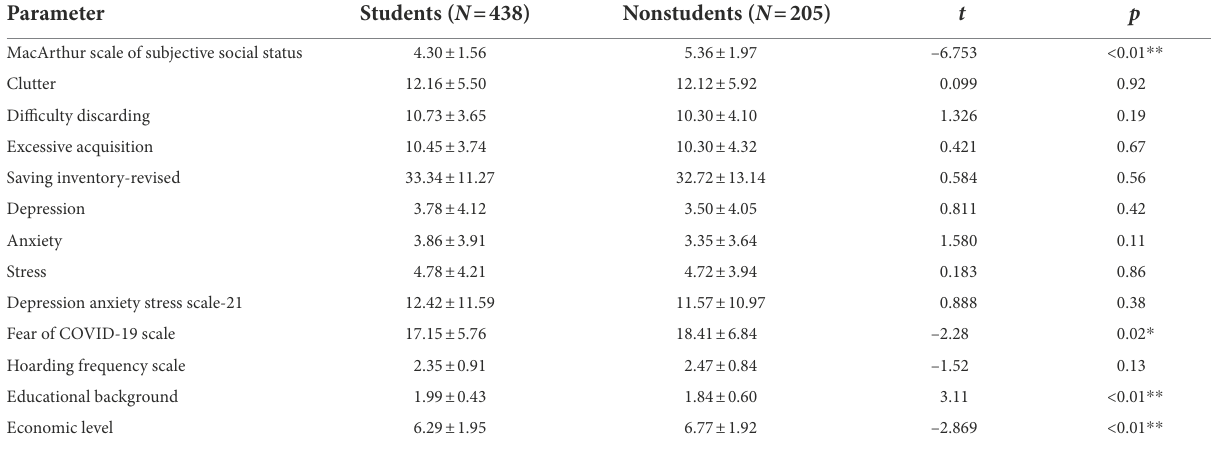
TABLE 3 Summary of data for each scale score comparison ( x ± s ).